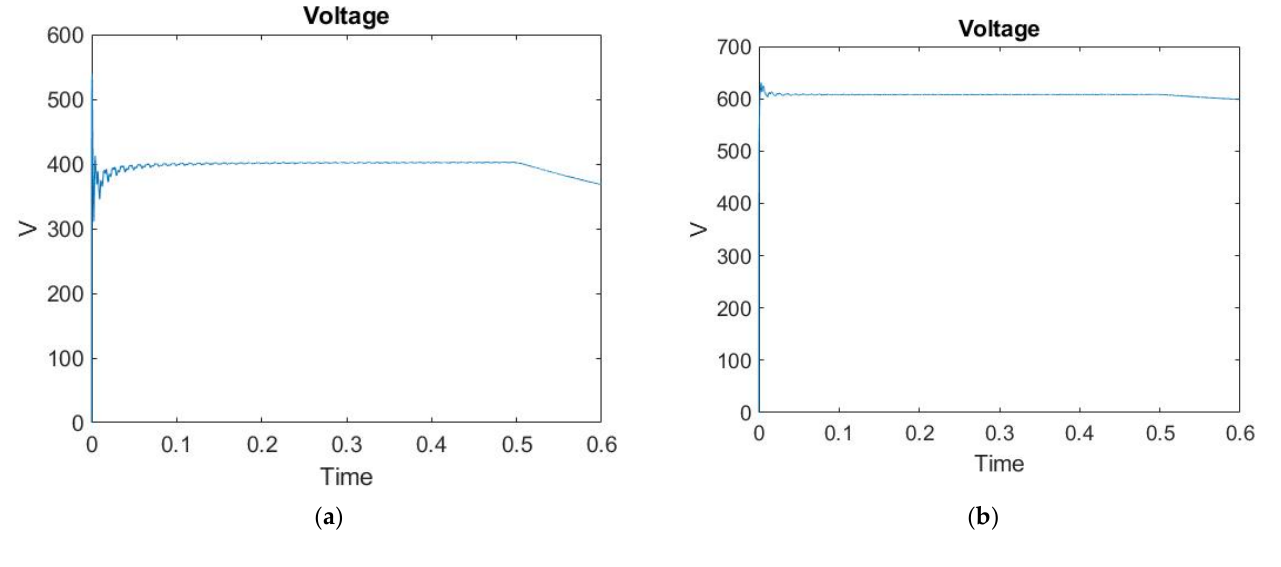
( d ) Figure 15. Output characteristics of induction motor: ( a ) speed; ( b ) flux; ( c ) torque and ( d ) current.